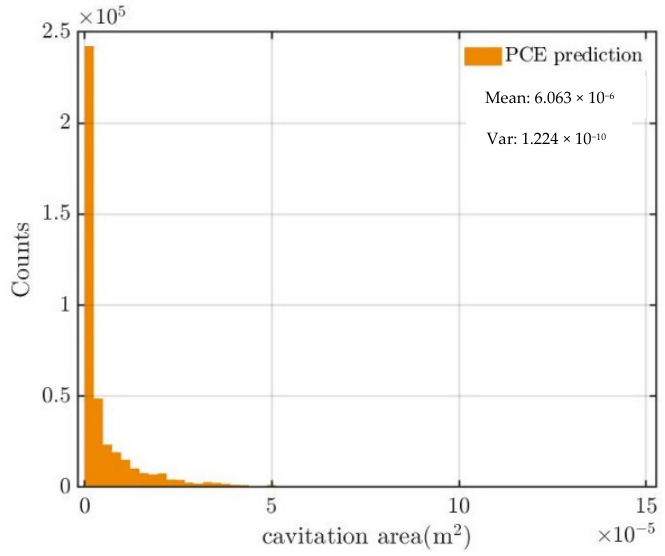
Figure 8. The histogram of the predicted cavitation area .